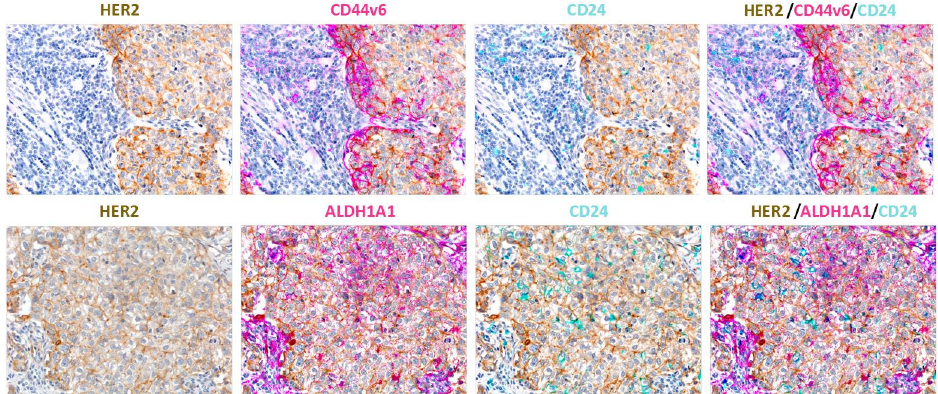
Figure 2. Triple-marker immunolocalization assessment of HER2 (brown signal), CD44v6 or ALDH1A1 (pink signal) and CD24 (cyan signal) in human breast cancer tissue samples. The results show different localizations of the two cell subsets. Original magnifications ×200.